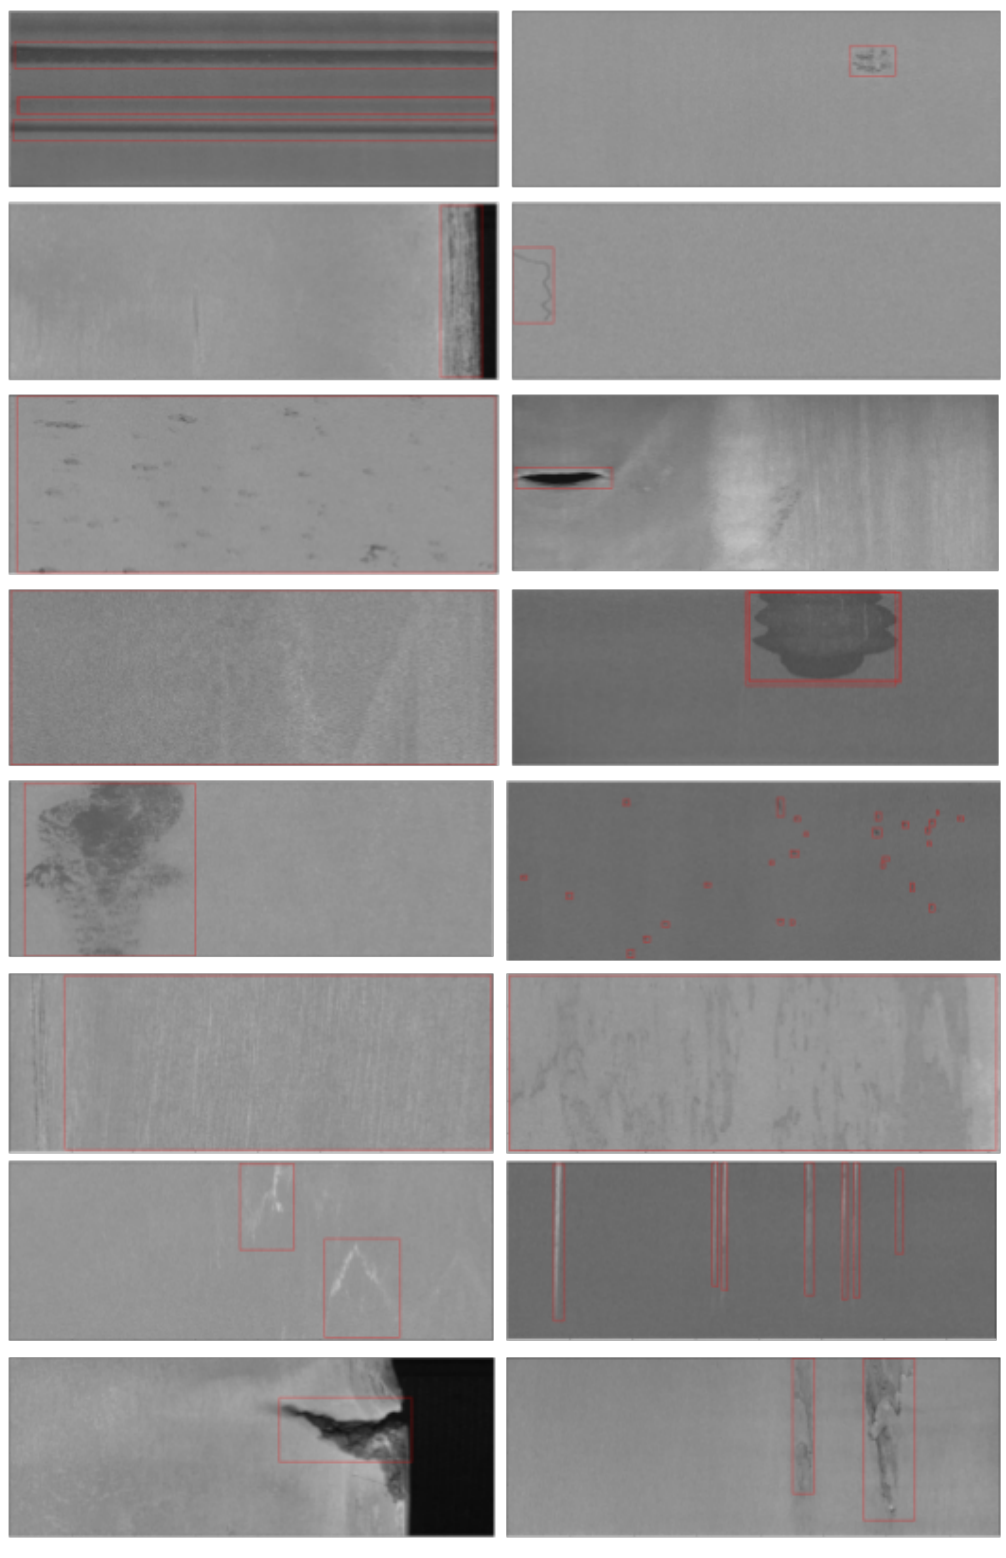
Figure 3. Defect types (first column: A–H, second column I–P). For illustration purposes only, bounding boxes are drawn around each defect. However, during training, the segmentation label consists of either a pixel-perfect or filled-in bounding-box mask as